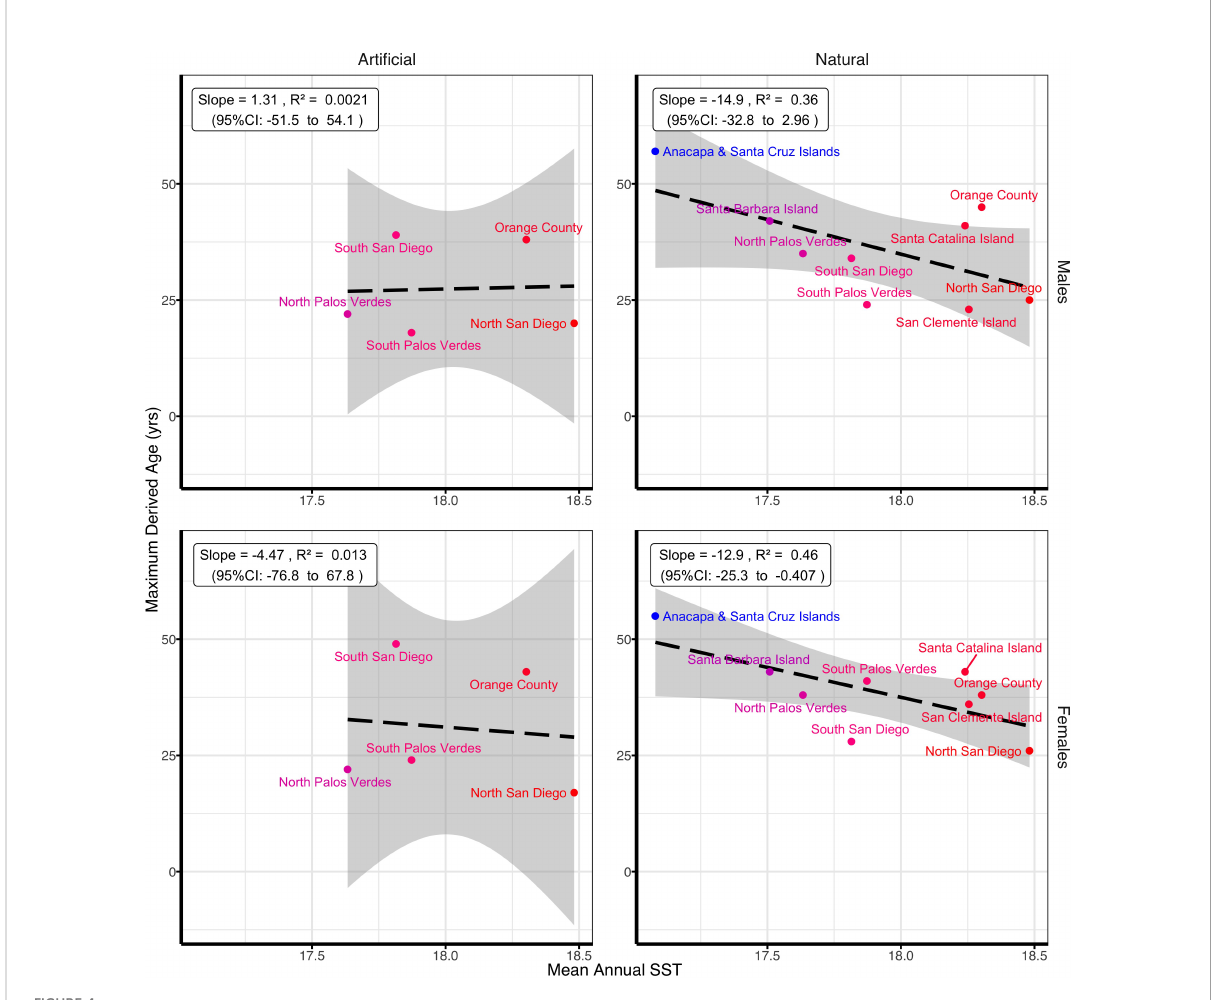
FIGURE 4 Relationship between maximum derived age (life span) of Garibaldi ( Hypsypops rubicundus) and mean annual sea surface temperature (SST; °C) for January 2002-December 2018. Locations are colored from a scale of blue (cold) to red